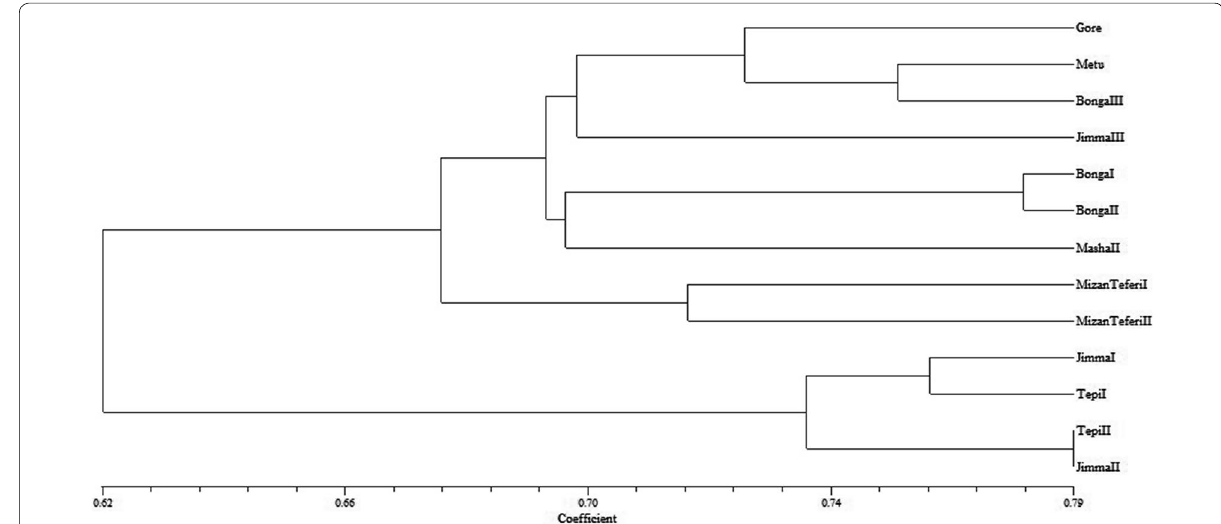
Fig. 4 Dendrogram of the 13 populations of Aframomum corrorima from Ethiopia generated from ISSR data using unweighted pair group method of arithmetic means (UPGMA). The algorithm is based on Jaccard’s coefficients of similarity obtained after pairwise comparison of the presence- absence